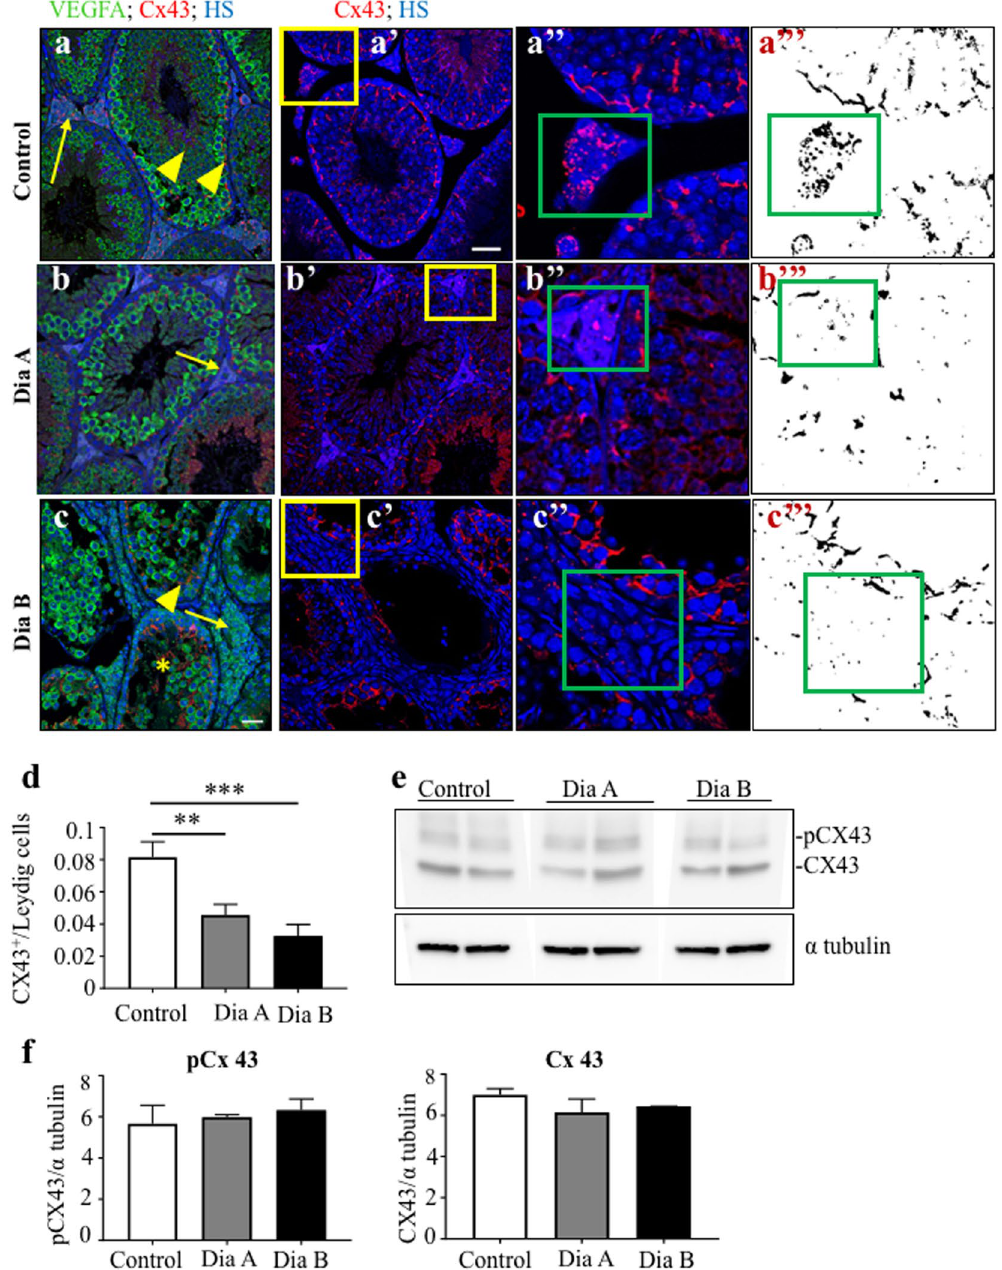
Figure 5. Cx43 expression in the testes of diabetic mice. Representative Cx43 staining of 8 μ m testis sections of the control testes ( a ); a strong Cx43 expression (red) is between Sertoli cells and between the apical part of spermatogonia and basal to primary spermatocytes (arrowheads). Type B spermatogonia and primary spermatocytes have a strong VEGFA expression (green). Cx43 is expressed in the clusters of Leydig cells (arrows). B: Cx43 expression pattern in Dia A is comparable to controls. ( c ) Increased Cx43 expression is detectable in the damaged seminiferous tubules with a high loss of cells in the diabetic testes (asterisks). ( a’ – c’ ) Representative images of Cx43 expression (red). ( a” – c” ) A detail of the interstitial area with Leyding cells. ( a”’ – c”’ ) Delineated Cx43 + area in the testis section by ImageJ program. Nuclei are counterstained with Hoechst 33342 (blue). Scale bar 50 μ m. ( d ) A relative quantification of staining determined as a ratio of Cx43 + areas per the total Leydig cell areas by ImageJ. The values represent means ± SEM (n = 3 individuals/3 sections/31 areas/ control group; 49 areas/Dia A group; 39 areas/Dia B group). ** P < 0.01, *** P < 0.0001 vs . Control by Dunnett’s post hoc tests. ( e ) Representative Western blot of Cx43 and phosphorylated form pCx43 with α tubulin loading controls in lysates of the testes of control and diabetic groups. ( f ) Quantitation of Cx43 and pCx43 Western blots relative to α tubulin. The values represent means ± SEM (n = 4 mice/group). Cx43, connexin 43; pCx43, phosphorylated connexin